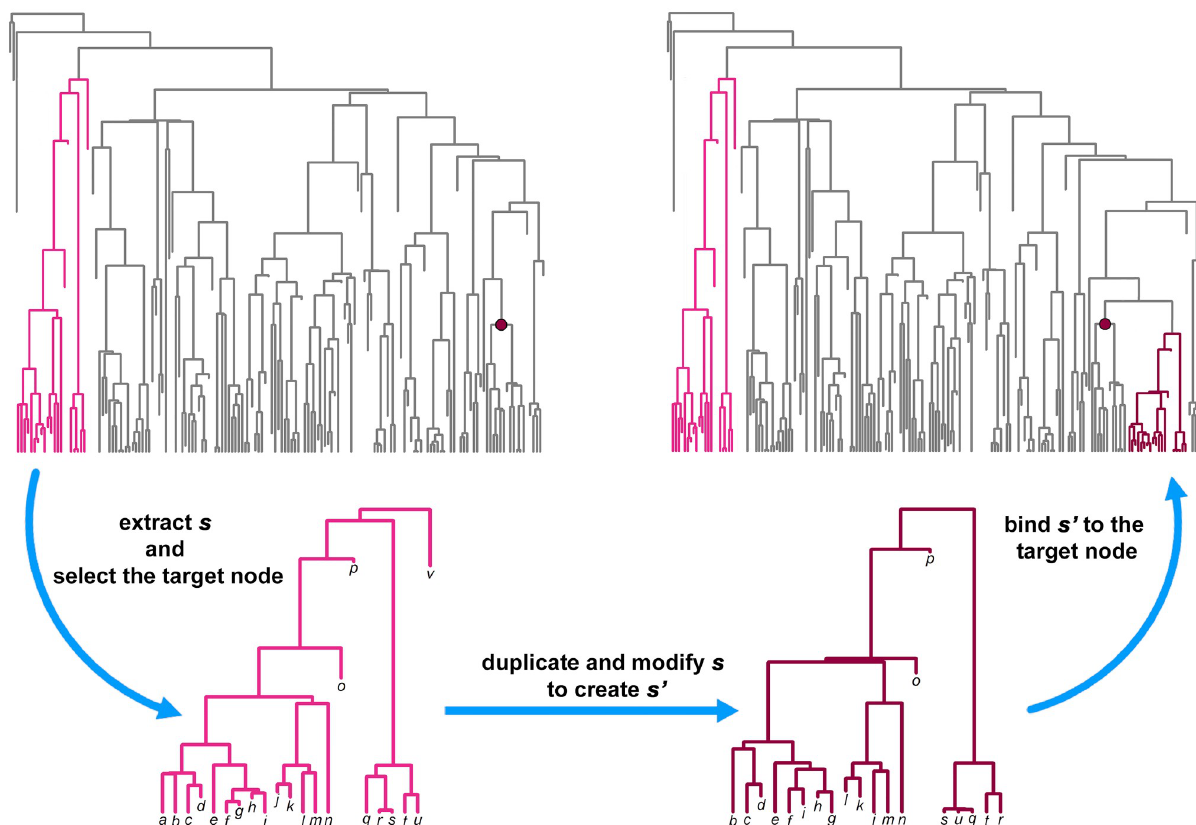
Fig 3. The procedure used to simulate convergence. Clades set to converge are colored. The focal clade ( s ) is indicated in bright pink, the modified clade ( s’ dark pink) is grafted at the target node indicated by the dark pink dot.